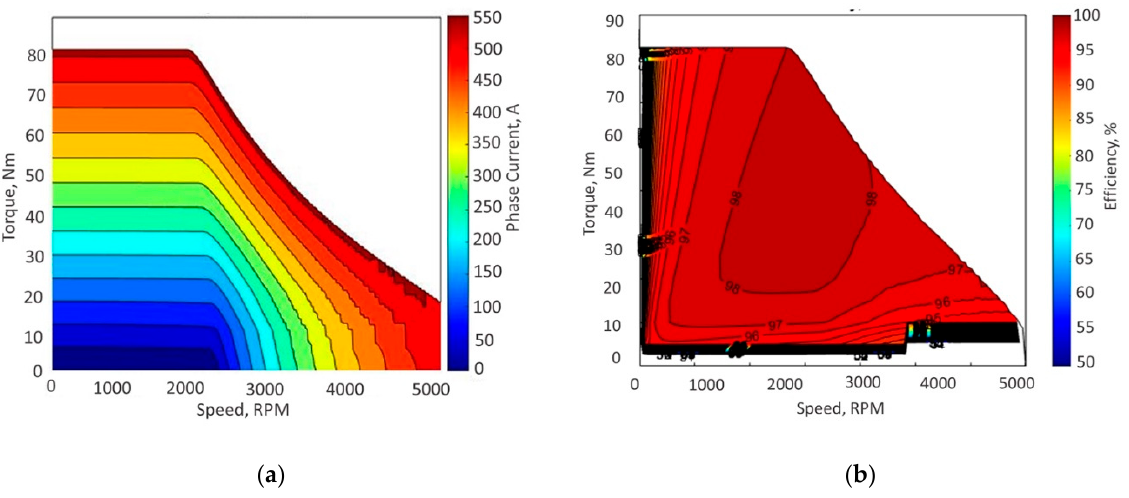
Figure 6. ( a ) Current requirement map of the IPMSM. ( b ) Efficiency maps of the